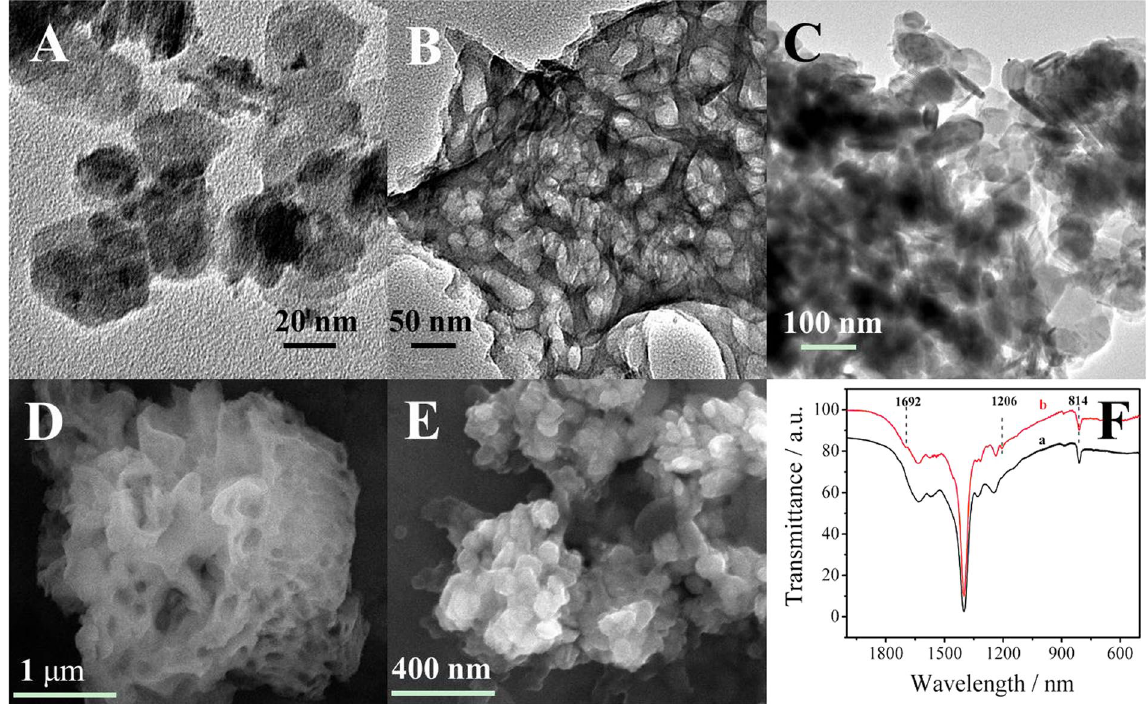
Figure 2. TEM image of ( A ) SnS 2 , ( B ) mpg-C 3 N 4 . ( C ) SnS 2 @ mpg-C 3 N 4 . FESEM image of ( D )mpg-C 3 N 4 , ( E ) SnS